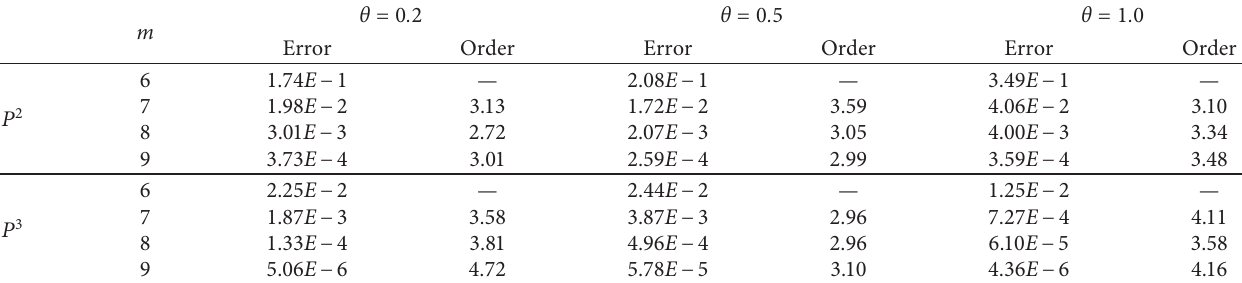
h for Example 1.